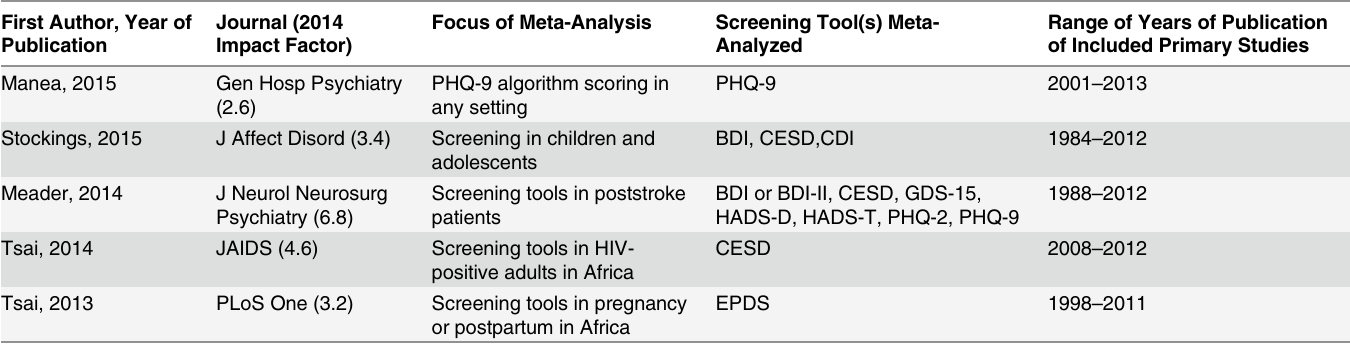
Table 1. Characteristics of Included